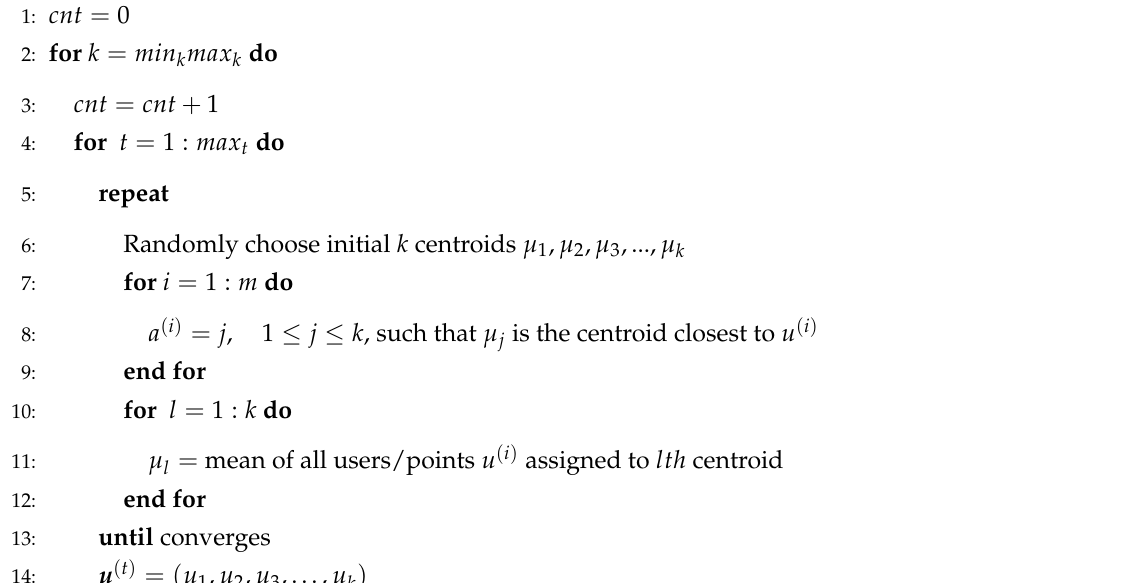
Algorithm 2 K-Means based users grouping